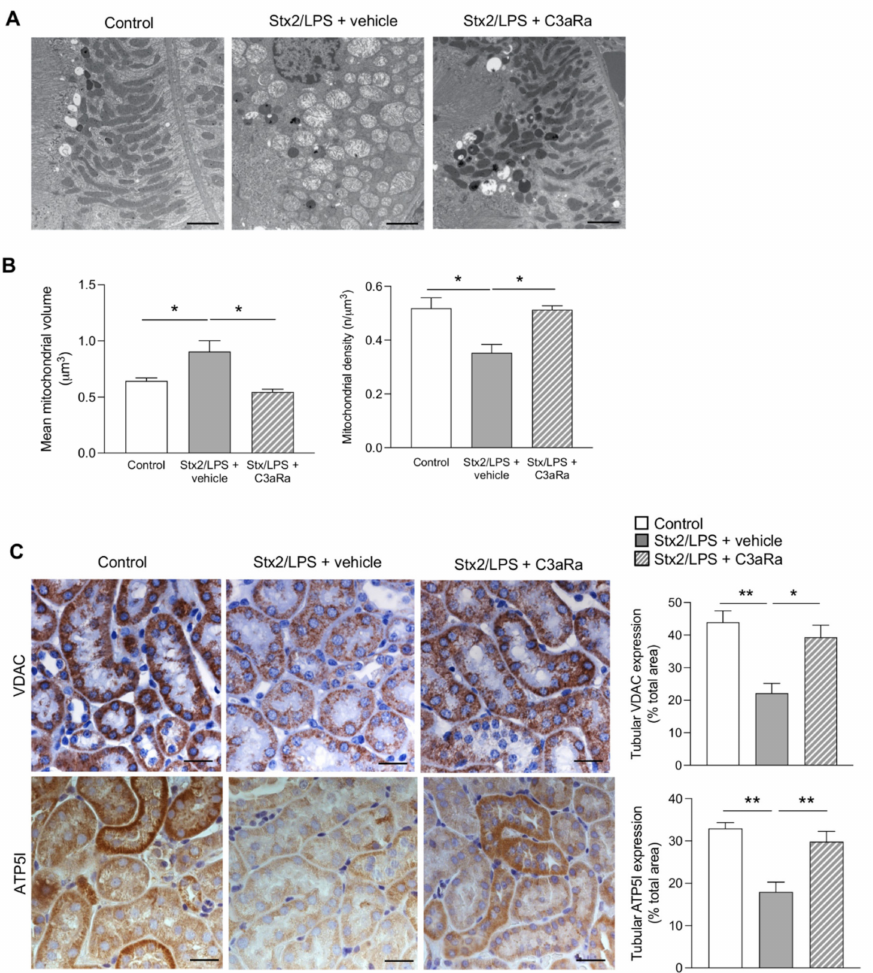
Figure 4. The C3aR blockade restores mitochondrial morphology and function in proximal tubular cells in Stx2/LPS mice. ( A , B ) Representative transmission electron microscope images and morpho- metric analysis showing mitochondrial morphology in proximal tubular cells of control and Stx2/LPS mice, given vehicle or C3aRa. Scale bars: 500 nm. Results are expressed as mean ± SEM (control: n = 6768 mitochondria analyzed in n = 3 mice; Stx2/LPS + vehicle: n = 4238 mitochondria